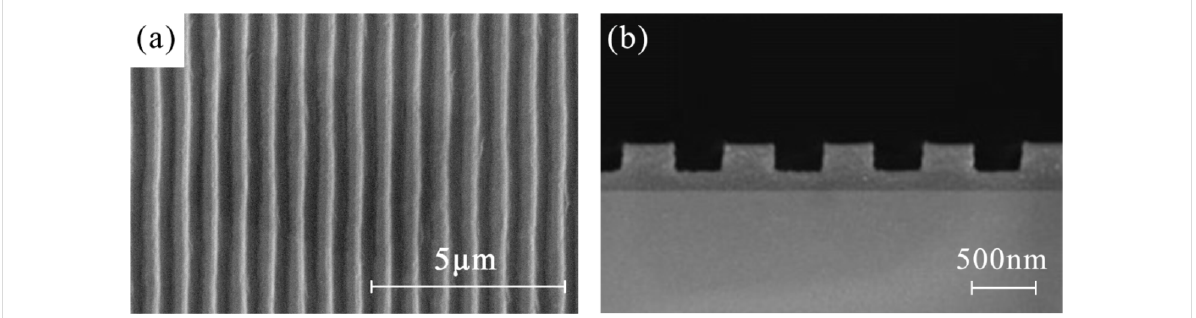
Figure 1: The SEM images of the fabricated photonic crystal film. (a) Top view, (b) cross-sectional view.